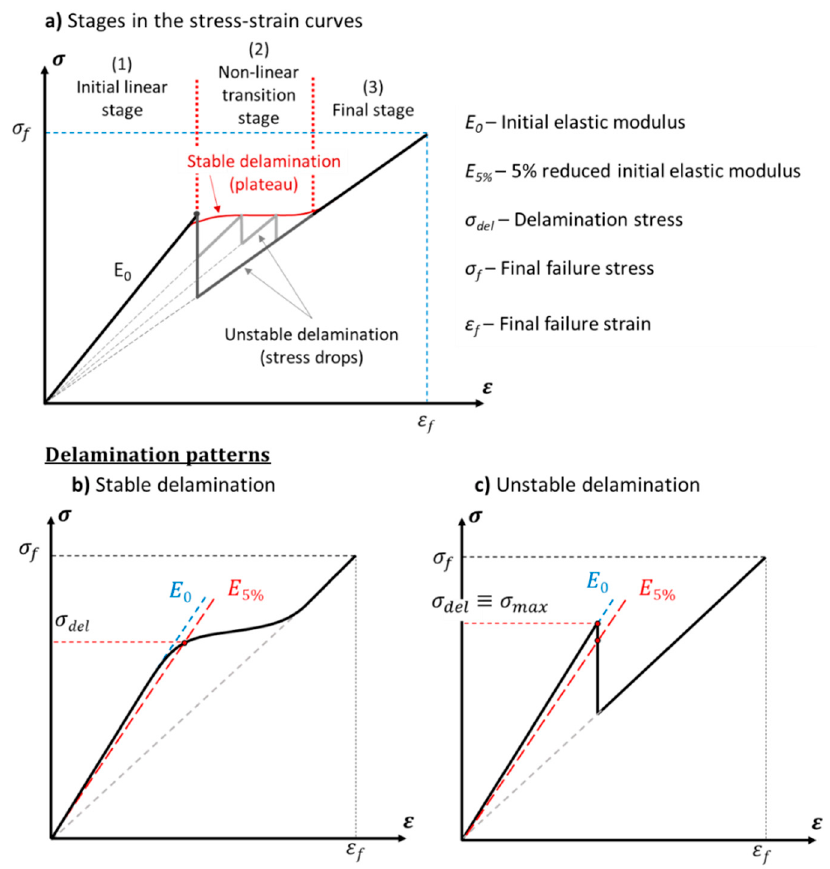
Figure 2. ( a ) Qualitative tensile stress-strain curves of the laminates and schematics of the ( b ) stable and ( c ) unstable delamination patterns.